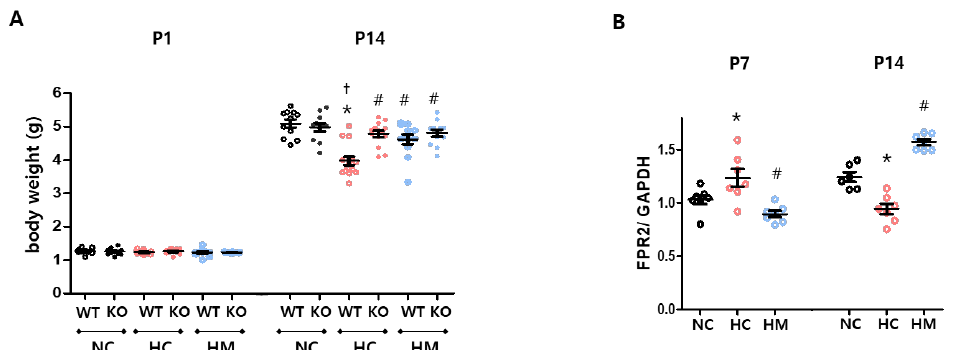
Figure 2. Changes in body weight and levels of FPR2. ( A ) Bodyweight measured at postnatal day 1 (P1; birth weight) and P14 in wild − type and FPR2 −/− mice. ( B ) Level of FPR2 normalized to GAPDH loading control in wild − type mice was measured at P7 and P14 (Full − length Western blots are shown in Supplementary Figure S4). Data are given as mean ± SEM. * p < 0.05 vs. NC in WT. † p < 0.05 vs. NC in KO. # p < 0.05 vs. HC in WT. WT, wild − type mouse; KO, FPR2 −/− mouse; NC, normoxia